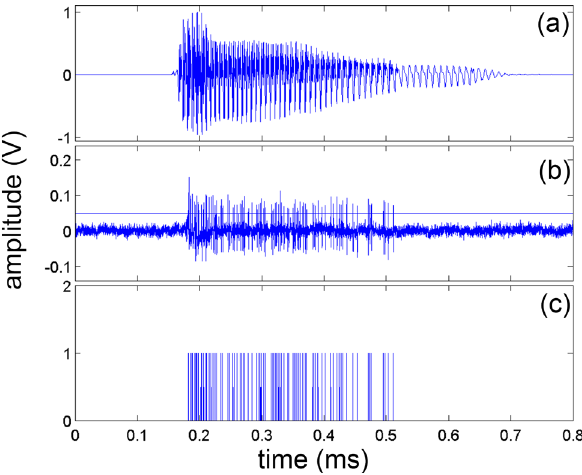
Figure 6. This figure shows the generation of a spike train from the neural recordings of the word “bomb.” ( a ) Shows the waveform of the word. ( b ) Shows a recording from a neural unit with a characteristic frequency of 500 Hz. The amplitude in ( b ) is 1000 times amplified. The threshold amplitude was at y = 0.05 ( b ), and each crossing of the threshold from low-to-high is an action potential or spike. ( c ) Shows the resulting spike train. At each peak in the spike train, a charge-balanced biphasic pulse was generated and presented through a cochlear implant. The best frequency of the spike sequence was matched as good as possible with the frequency place map established for the cochlear implant